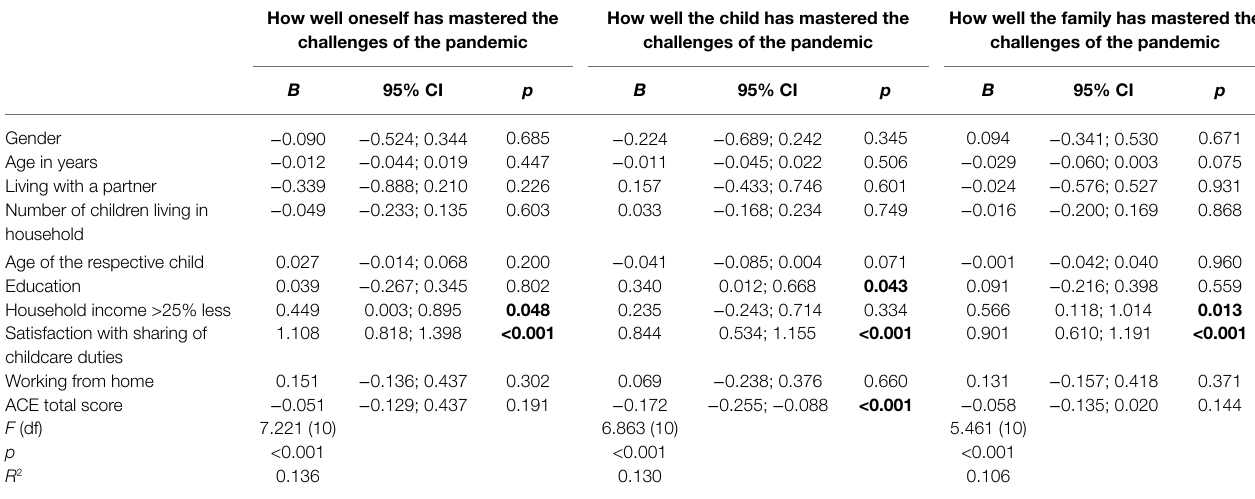
TABLE 3 | Factors associated to coping of the pandemic. How well oneself has mastered the challenges of the